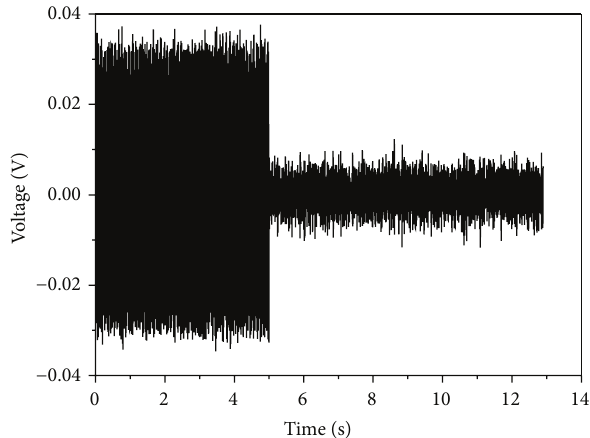
Figure 11: Change of self-induced voltage from position 2 to position 3.